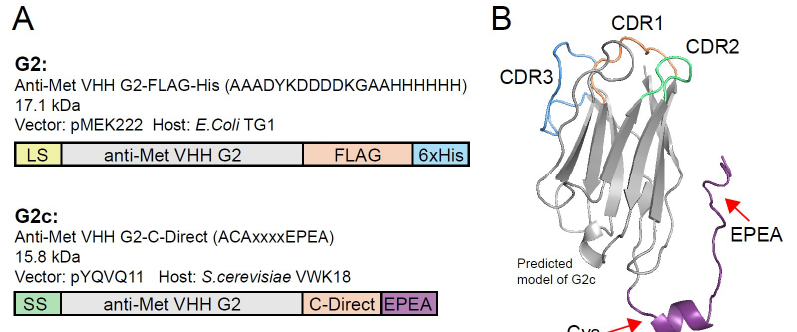
Figure 2. Production of G2 with a C-terminal tag containing a free thiol (G2c) and conjugation to PS. ( A ) Schematic representation of the anti-Met VHH G2, expressed as a FLAG-His tagged protein (top) and G2c carrying an additional cysteine in its C-terminal C-Direct tag. The molecular weights of the proteins are indicated, as well as the expression vector and production organism used. LS, pelB leader sequence. SS, Suc2 secretion sequence. ( B ) Predicted model of G2c in which the C-terminal tag (purple) containing the unpaired cysteine and the EPEA (Glu, Pro, Glu, Ala) affinity tag is indicated with red arrows. CDRs (complementarity determining regions) are located on the opposing end of the VHH. The model was based on the structure of Nb10 (85% amino acid sequence homology with QME-G2) as published by Park et al. (PDB ID 4DKA:A, C-score 0.13) [27].